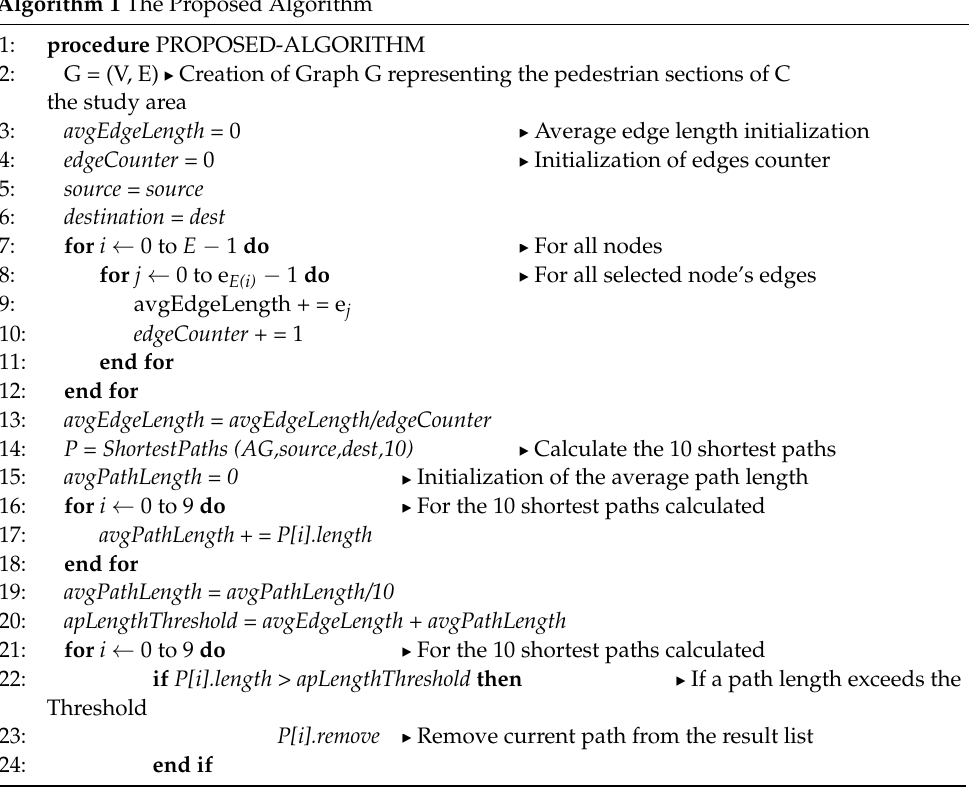
Algorithm 1 The Proposed Algorithm